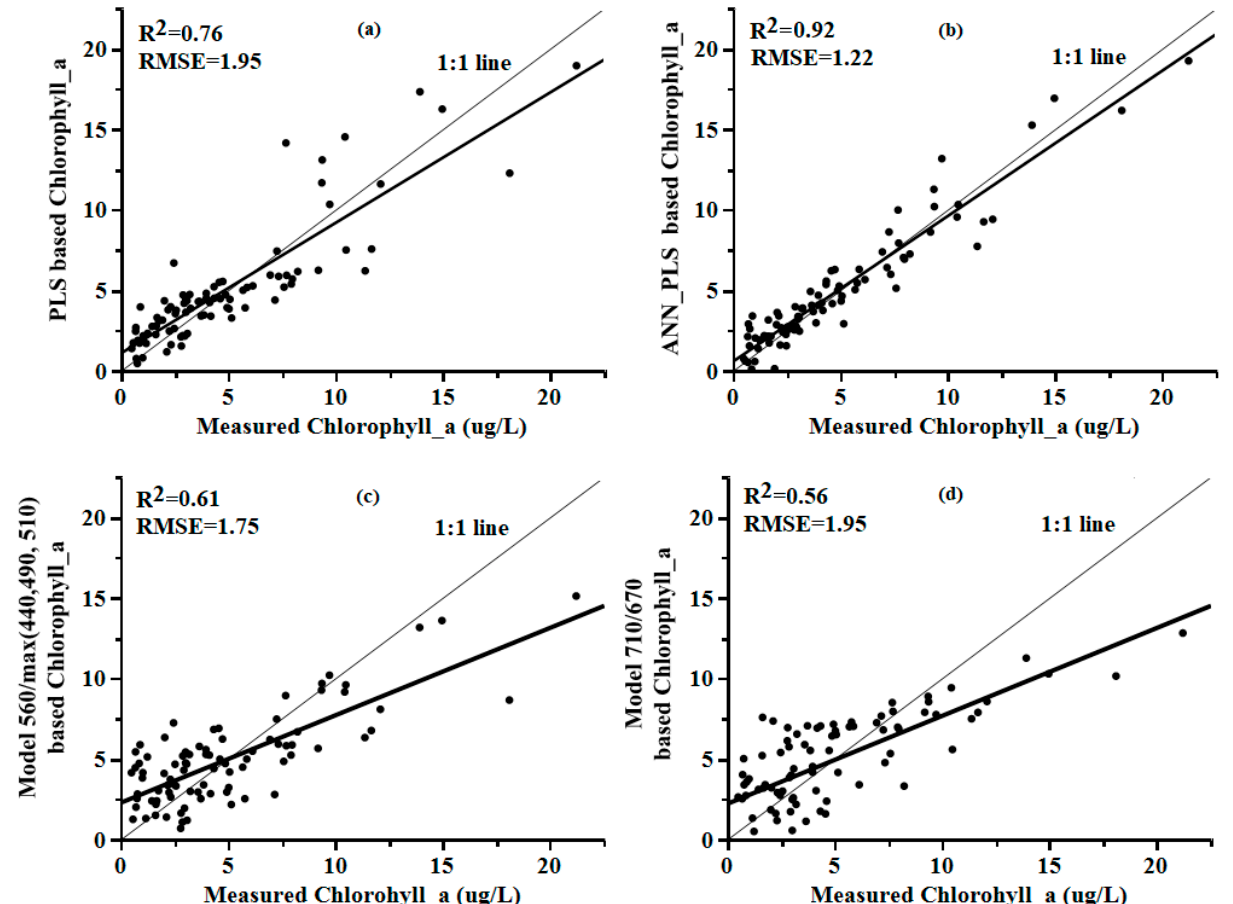
Figure 7. Linear and non-linear relationship of PLS components and chlorophyll-a.